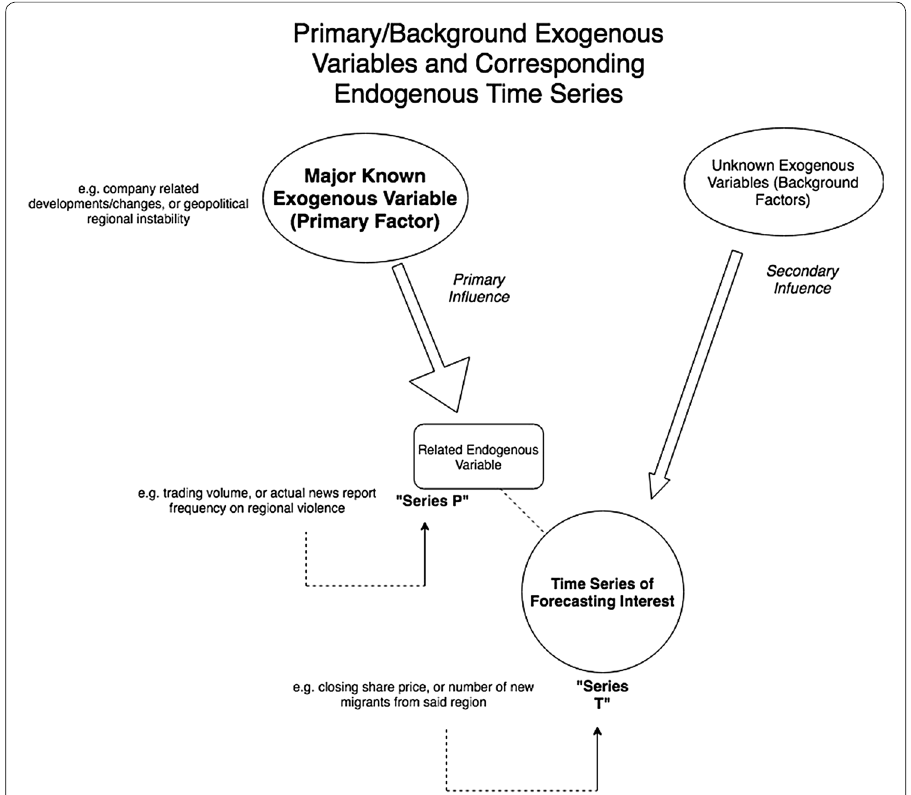
Fig. 1 A basic map of how the relationship between exogenous and endogenous variables are understood in the new